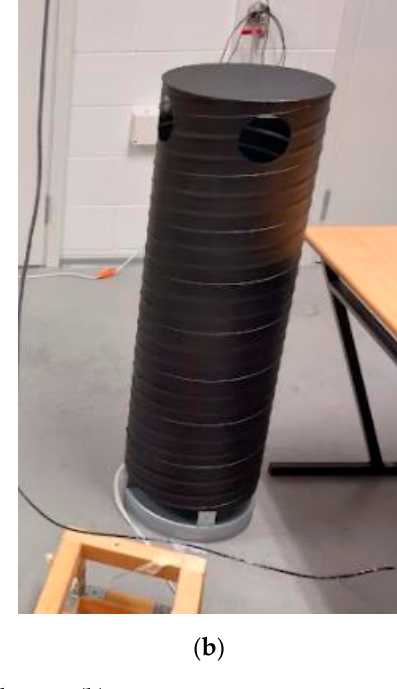
Figure 3. Measuring tripod ( a ) and heating dummy ( b ).